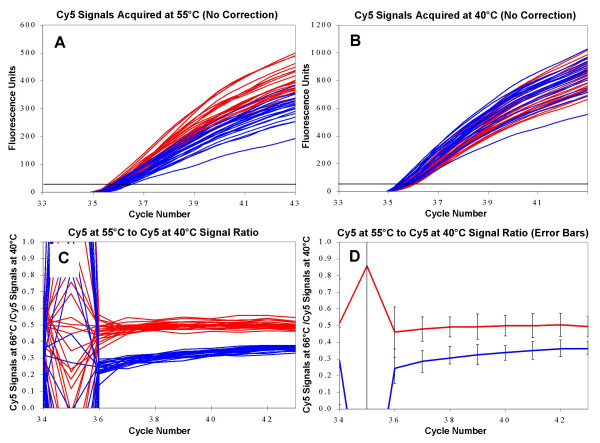
Two-Temperature LATE-PCR Genotyping. Panel A: Kinetic plots of ResonSense® Cy5 signals collected at 55°C, a temperature at which the probe is allele-discriminating and binds exclusively to the normal allele. Under allele discriminating conditions, replicate homozygous normal samples (red lines) have, on the average, higher fluorescence signals than heterozygous replicates (blue lines) but signal scatter prevents identification of individual genotypes based on this type of kinetic analysis. Panel B: Kinetic plots of ResonSense® Cy5 signals collected at 40°C, a temperature at which the probe becomes mismatch-tolerant and binds both the TSD normal and G269 alleles. Under mismatch-tolerant conditions, homozygous replicates (red lines) and heterozygous replicates (blue lines) exhibit, on the average, very similar fluorescence signals which reflect the total amount of amplification product in each tube. Panel C: Plot of ratio of Cy5 fluorescence signals collected under allele-discriminating (Panel A) and mismatch-tolerant (panel B) conditions. Normalization using the ratio of fluorescent signals collected at temperatures permissive for either allele-specific or mismatch-tolerant probe binding generates characteristic fluorescent signatures that are unique to each genotype. Once established, these signatures do not vary significantly as a function of the extent of the amplification reaction making them suitable for endpoint analysis (red lines, homozygous samples; blue lines, heterozygous samples). Panel D: Statistical analysis of data in Panel C. Red and blue lines correspond to the average fluorescence values of each replicate set of homozygous normal and heterozygous samples, respectively. Error bars correspond to three-standard deviations of the mean which encompasses 99.7% of all possible samples in each replicate set distribution. The absence of overlap between the error bars two cycles after the fluorescent signals ratio is first above background demonstrates that homozygous normal and heterozygous samples can be unambiguously identified by this method with 99.7% certainty.